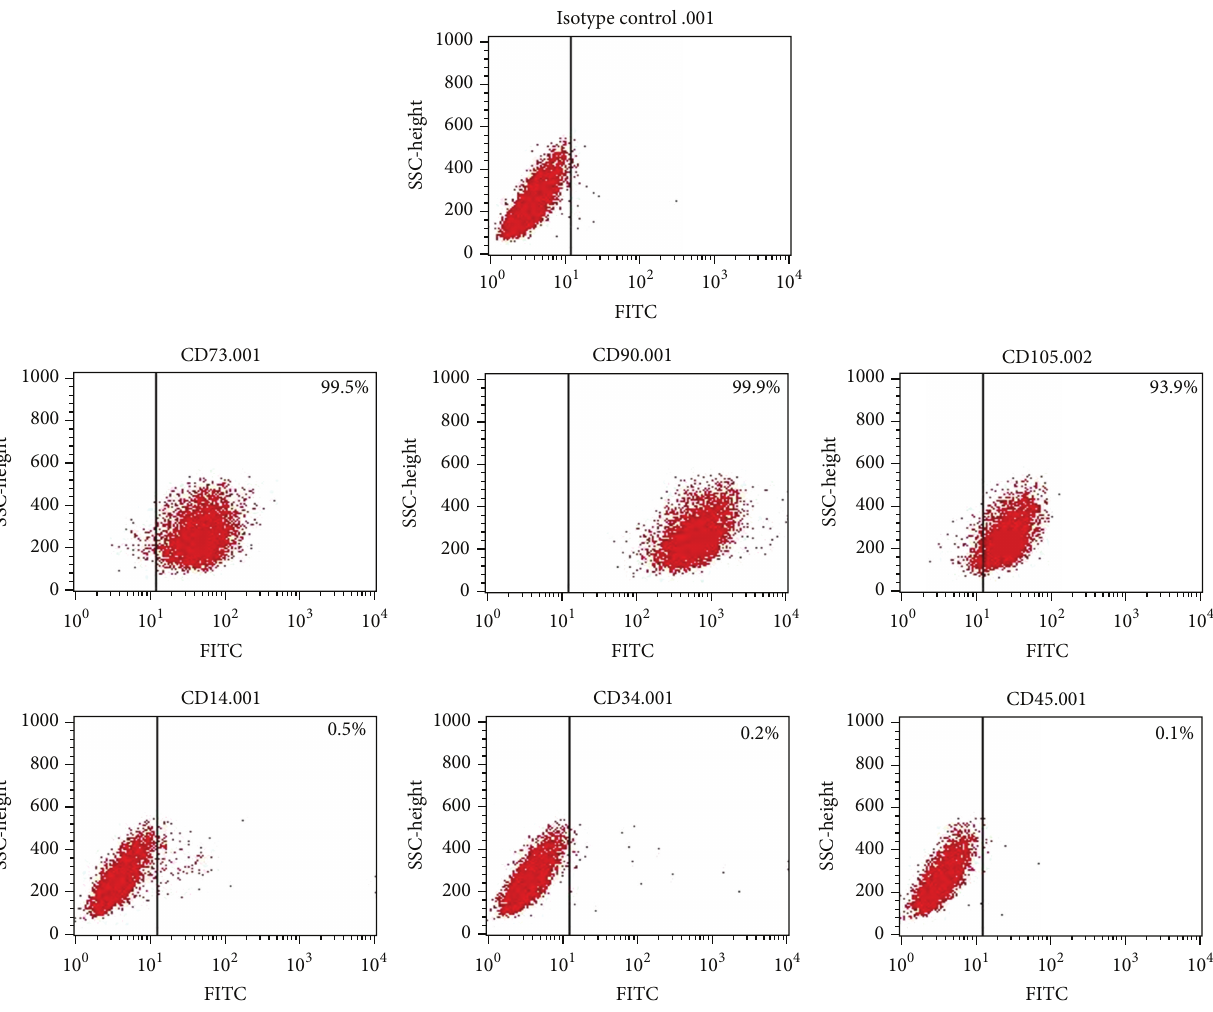
Figure 2: Third-passage hUCMSCs are positive for CD73, CD90, and CD105, while being negative for CD14, CD34, and CD45 as detected by flow